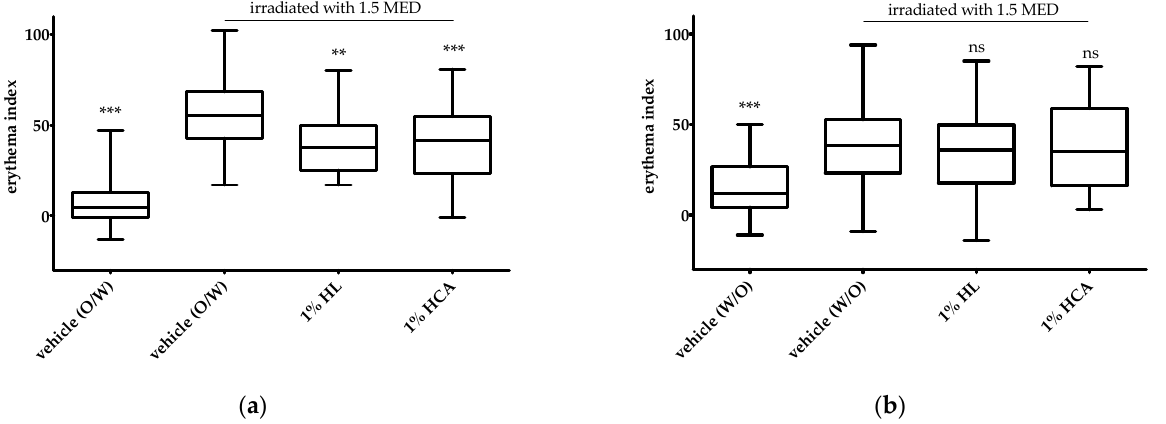
Figure 4. Effect of an O/W cream ( a ) and a W/O cream ( b ) with 1% HL ( Humulus lupulus ) extract or 1% HCA (hydrocortisone acetate) on skin erythema of non-irradiated skin ( n = 40); The statistical significances were calculated in relation to the vehicle. ns: not significant, *** p ≤ 0.001. In the UVB erythema test, the actives (1% HL extract or 1% HCA) incorporated in the O/W formulation showed a statistically significant reduction of the erythema (Figure 5a).